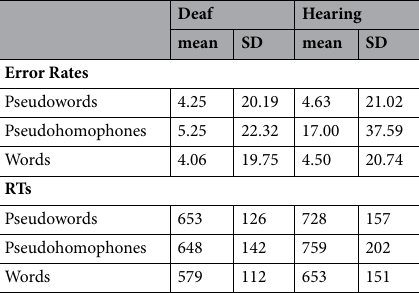
Table 1. Average and SDs of error rates and RTs for each condition for Experiment 2 (lexical decision task).